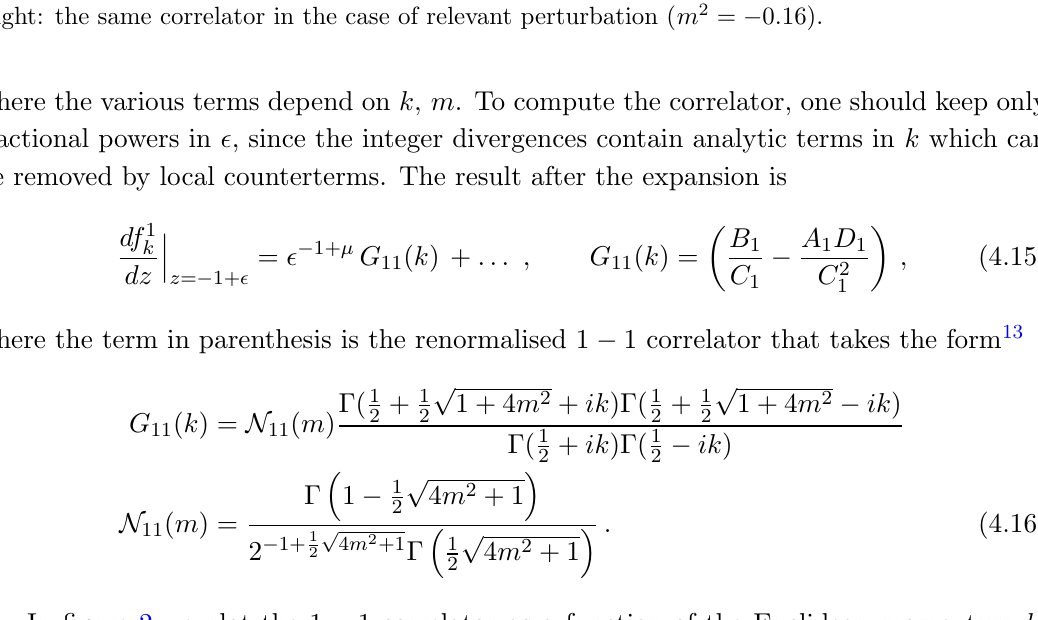
Figure 2 . Left: the 1 (cid:0) 1 correlator with m = 1 as a function of k . In the UV it is like the usual 2 AdS 2 correlator while in the IR it is gapped with the gap depending on the value of the mass m . Right: the same correlator in the case of relevant perturbation ( m 2 = (cid:0) 0 :